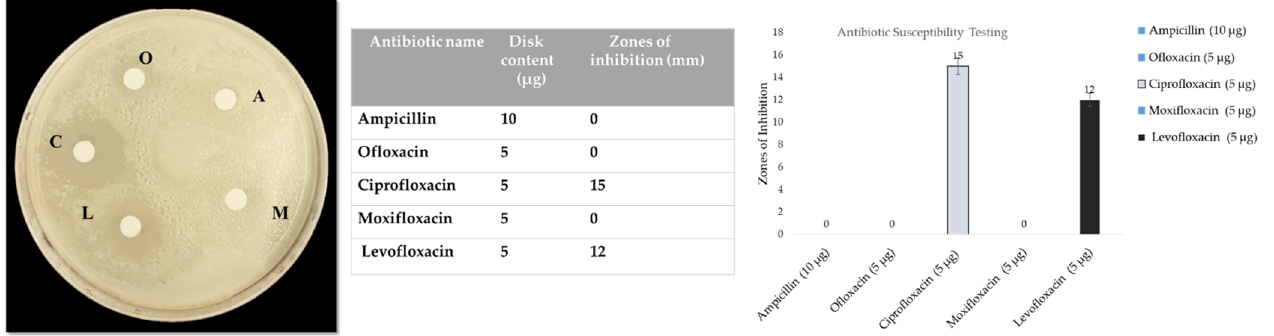
Figure 2. Antibiotic susceptibility testing for clinical strain of S. aureus.